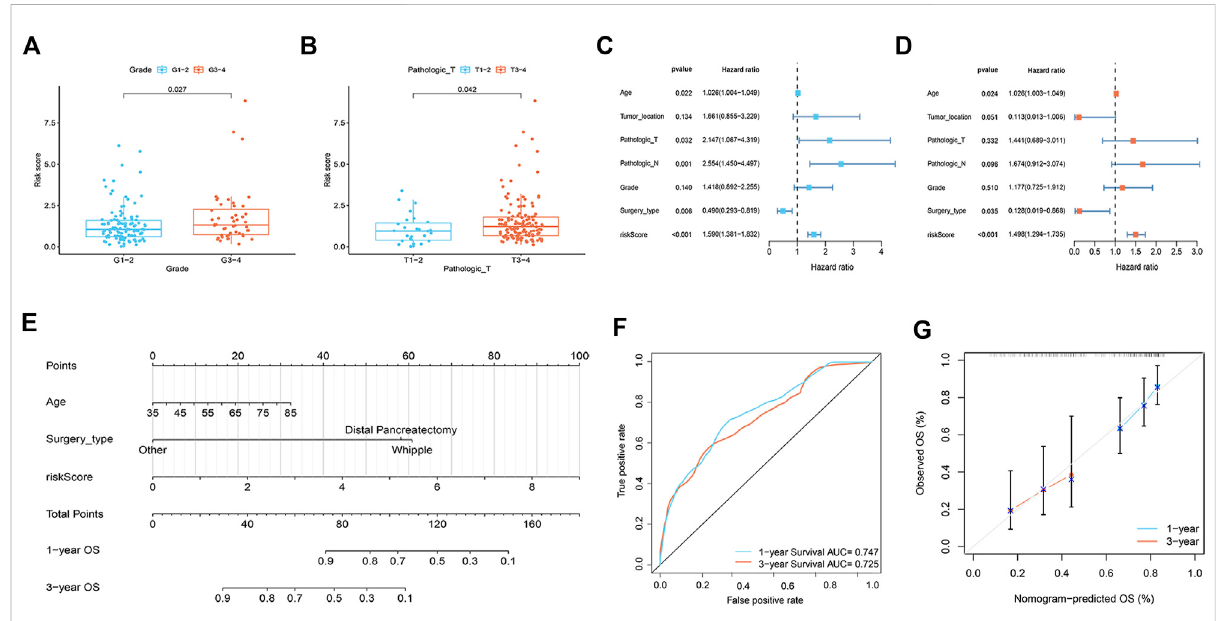
FIGURE 2 Correlation analysis and nomogram construction ( n = 161). (A) The relationship between risk score and tumor grade. (B) The relationship between risk score and pathologic T stage. (C,D) Forest plots of univariate (C) and multivariate (D) Cox regression analysis, including risk scores and clinicopathologicalvariables. (E) The nomogram ofcombined riskscoreand clinicalparameters. (F) ROC curvewasusedto evaluate theaccuracyof nomogram. (G) Calibration plots for predicting OS rates at one and 3